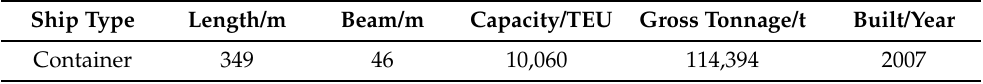
Table 1. Information of the research object, a container